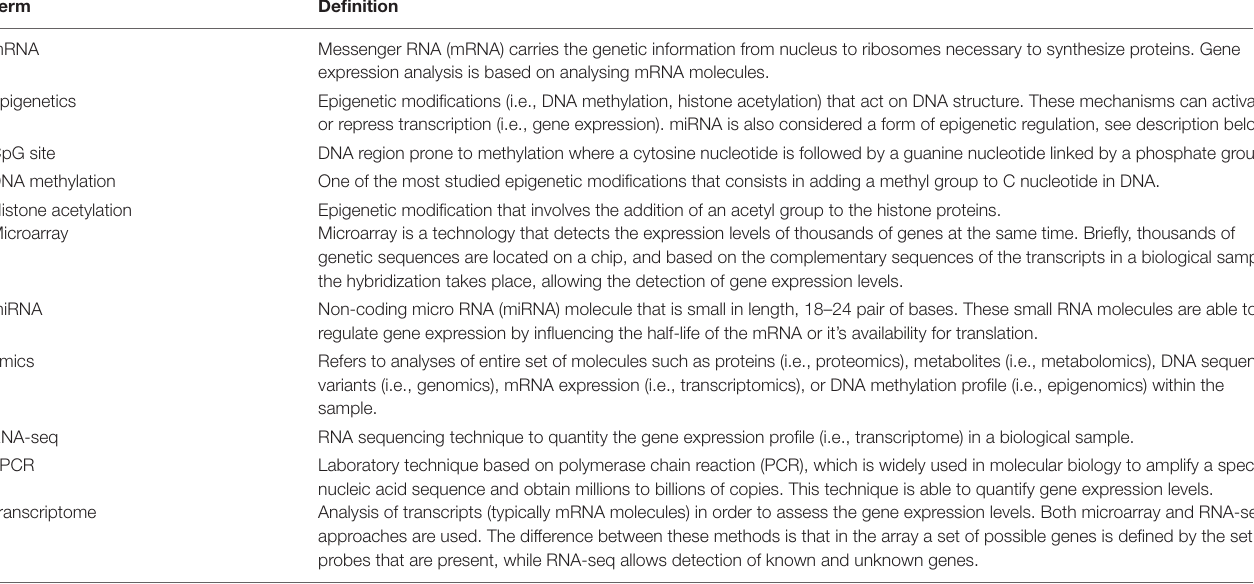
TABLE 1 | Definition of the main molecular biology-related terms used in this systematic review.